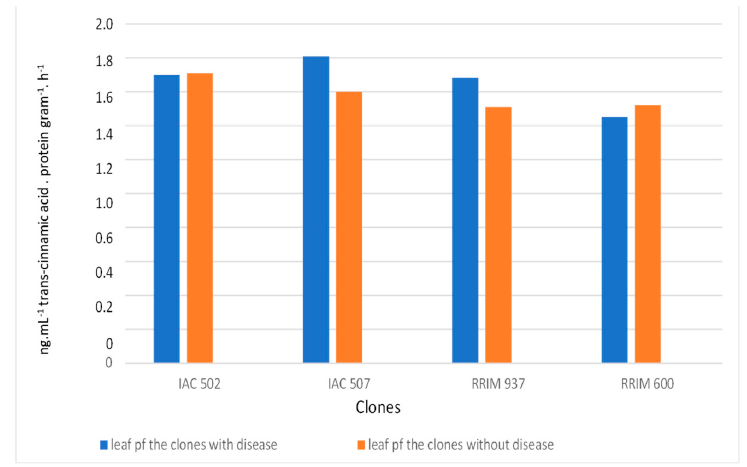
Figure 6. Activity of the enzymes PAL in the leaves of rubber trees with and without the presence of anthracnose. Non-significant difference (5% F test).